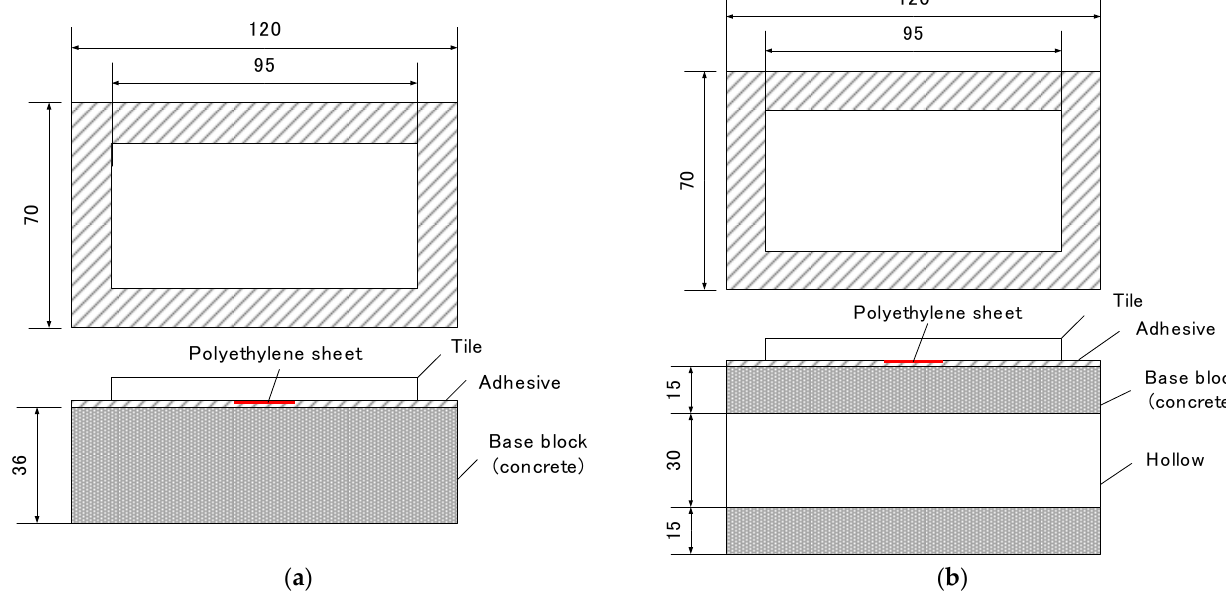
Figure 6. Test examples of the block: ( a ) normal type; ( b ) hollow type.